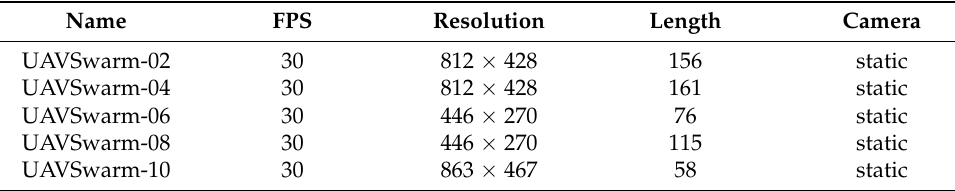
Table 2. Overview of the testing sequences in the UAVSwarm